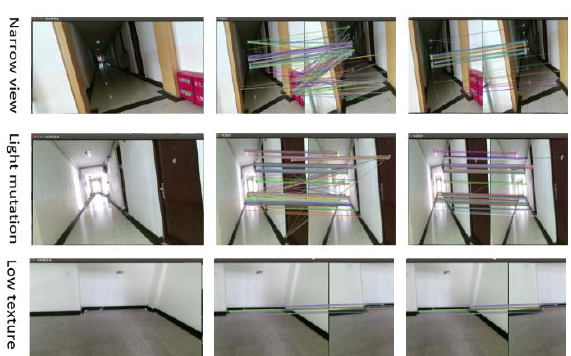
Fig. 4 ORB-SLAM lost tracking and scene correlation analysis